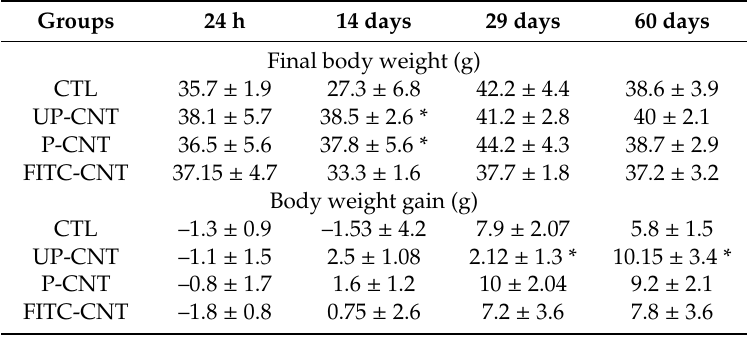
Table 1. Body weight and weight gain (g) in mice exposed to different CNTs and at different exposure times.